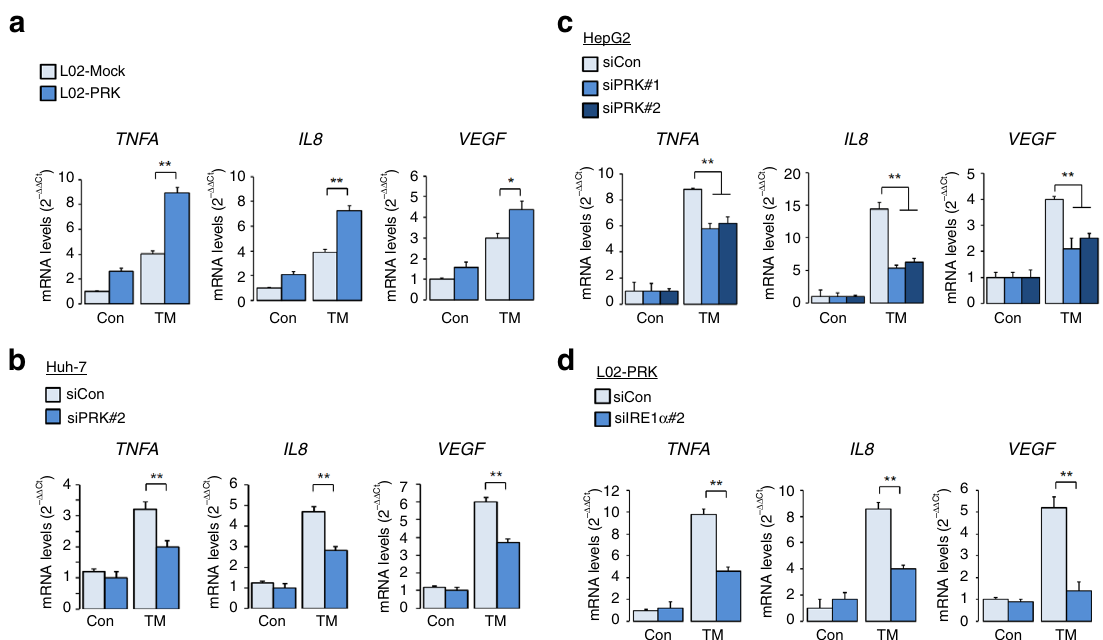
Fig. 8 PRKCSH enhances expression of tumor-promoting cytokines under ER stress. a Quantitative real-time PCR analysis of tumor-promoting cytokines in L02-Mock and L02-PRK cells treated with 10 μ g/mL TM for 5 h. b Quantitative real-time PCR analysis of tumor-promoting cytokines in PRKCSH-silenced Huh-7 cells treated with 10 μ g/mL TM for 5 h. c Quantitative real-time PCR analysis of tumor-promoting cytokines in PRKCSH-silenced HepG2 cells treated with 10 μ g/mL TM for 5 h. d Quantitative real-time PCR analysis of tumor-promoting cytokines in IRE1 α -silenced L02-PRK cells treated with 10 μ g/ mL TM for 5 h. Data are shown as mean ± SEM from three or four independent experiments. One-way ANOVA; * P < 0.05, ** P < 0.01